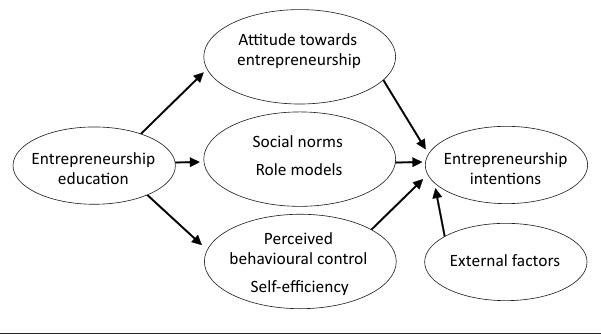
FIGURE 2: Integrative Model for Assessing Entrepreneurial